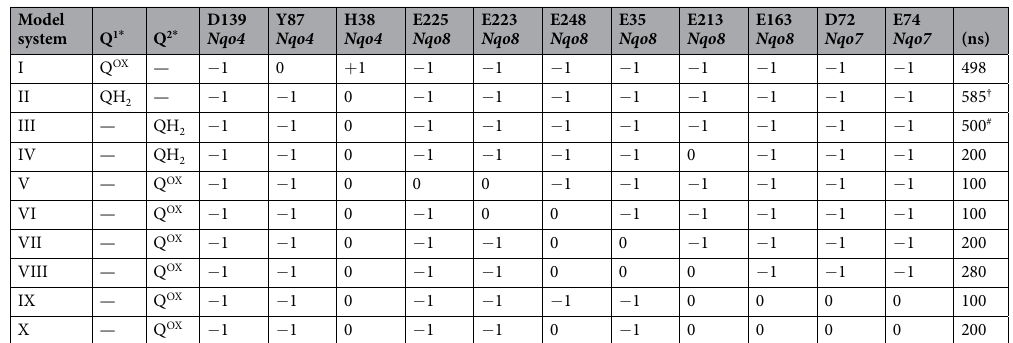
Table 1. Model systems and simulation lengths. * The Q is modeled as Q OX (oxidized) or QH 2 (doubly reduced and doubly protonated) at the site close to N2 FeS center (Q 1 ) or at another location half-way through the Q tunnel (Q 2 ) (see Methods section). † Including five independent ~5 ns simulations. # Including one 266 ns and three independent ~80 ns simulations with QH 2 modeled at few different locations in the middle region of the